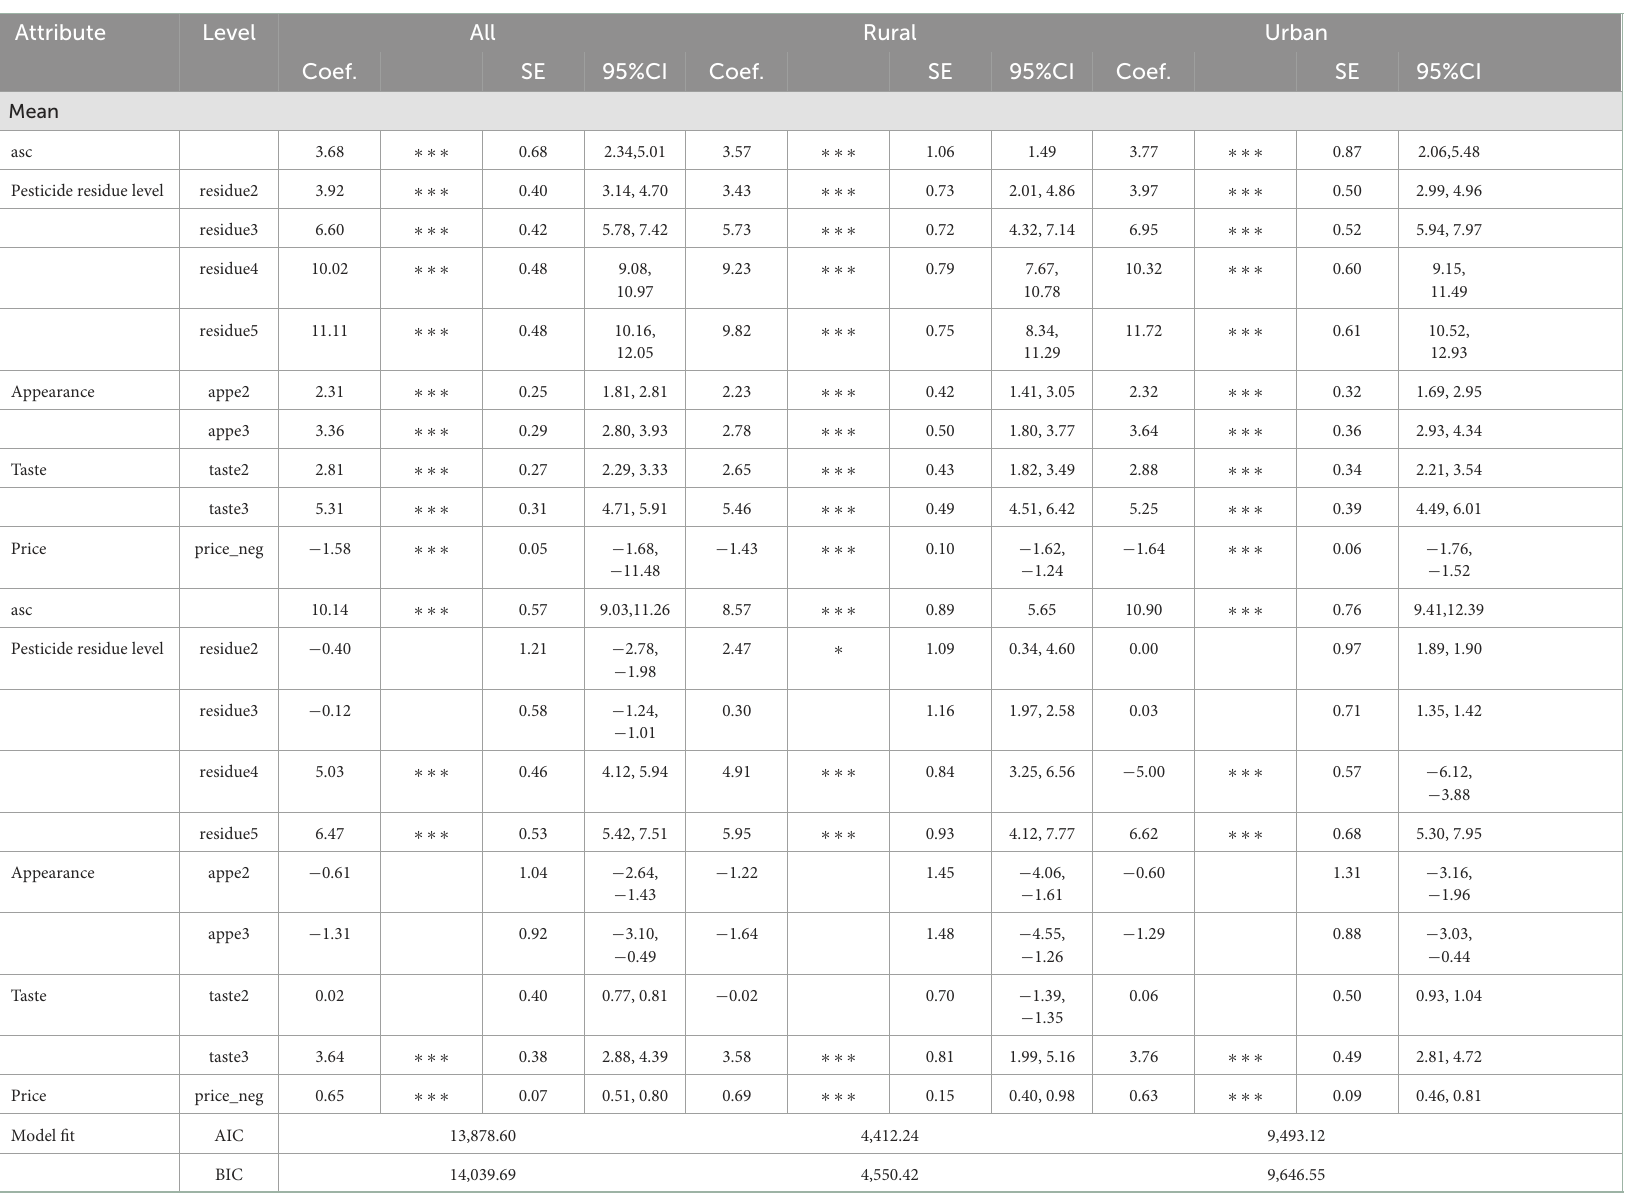
TABLE 7 Mixed logit model in WTP